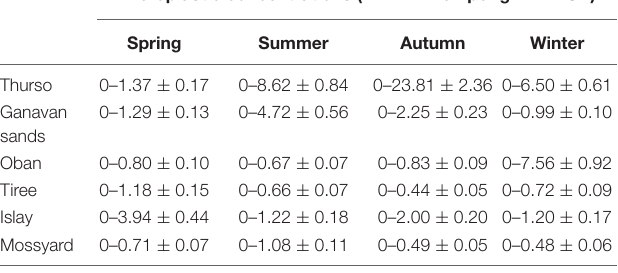
TABLE 4 | Minimum and maximum concentrations of microplastics recorded per g of soft tissue wet weight with the standard errors for each site and season. Microplastic concentrations (N ◦ min–max per g.ww ± SE